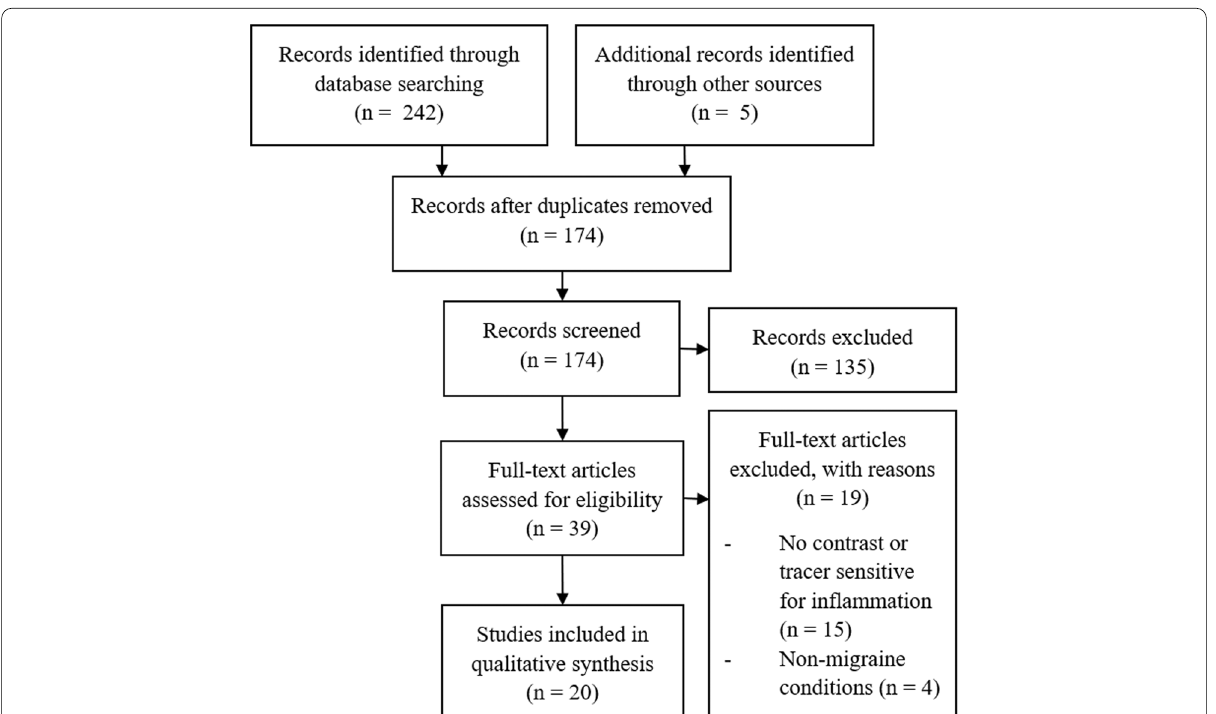
Fig. 1 Preferred Reporting Items for Systematic Reviews and Meta Analyses (PRISMA) workflow chart of identified, excluded and included